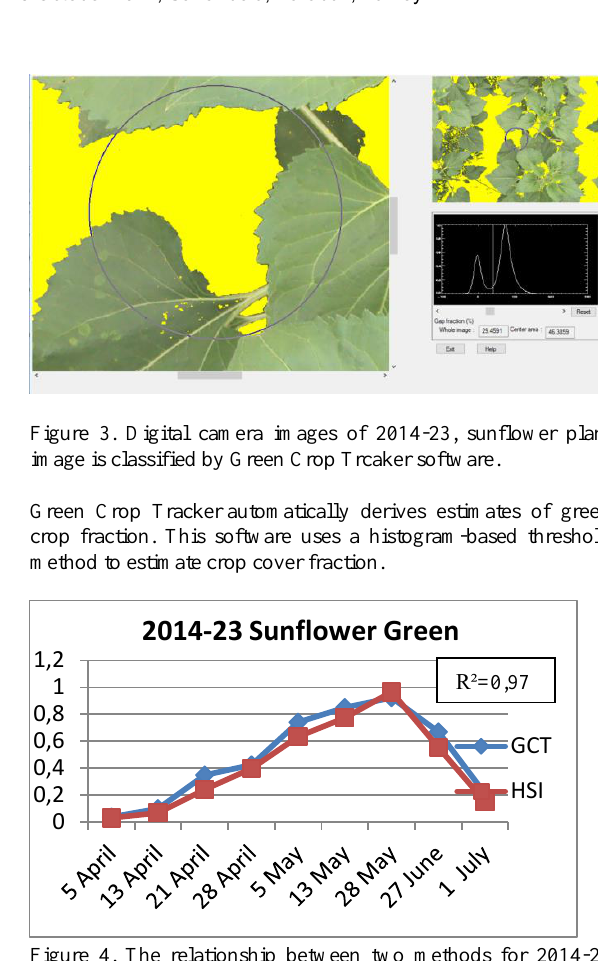
Figure 4. The relationship between two methods for 2014-23 sunflower